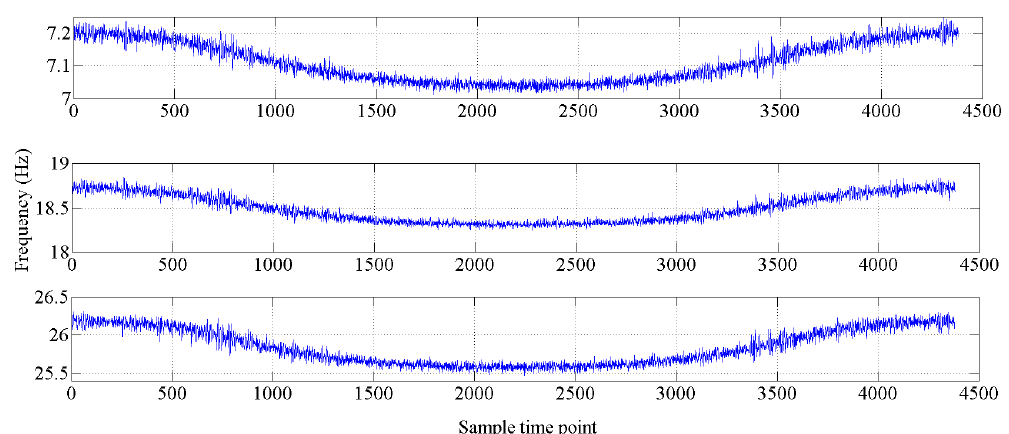
Figure 6. Changes in the natural frequencies (mode 1 to mode 3).